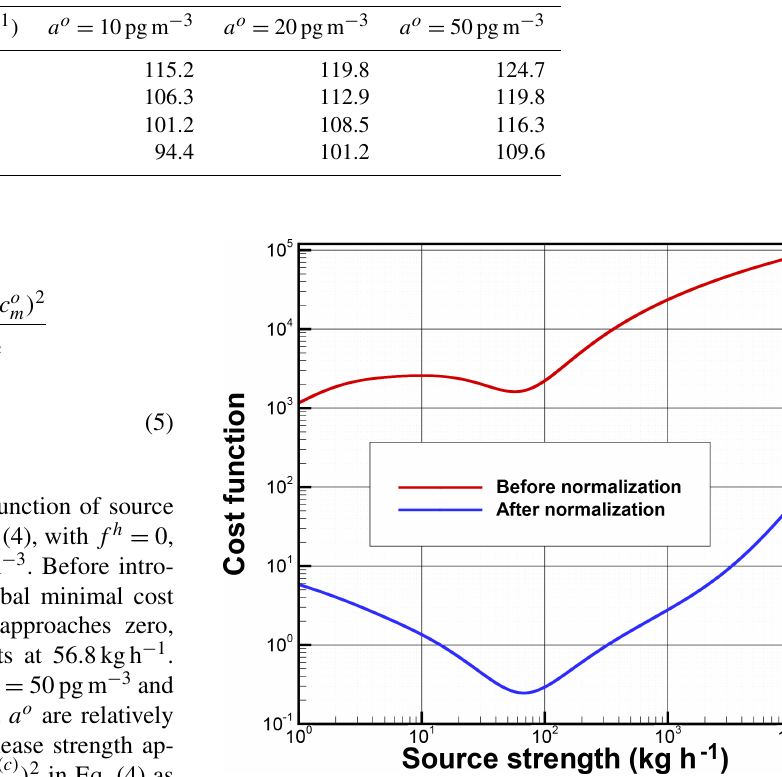
Table 3. Emission strength of release 2 that minimizes F for different observational errors, defined as (cid:15) = f o × c o + a o . Logarithm concen- tration is chosen as the metric variable; i.e., (c h m − c o m ) in Eq. (1) is replaced with ln (c h m ) − ln (c o m ) .